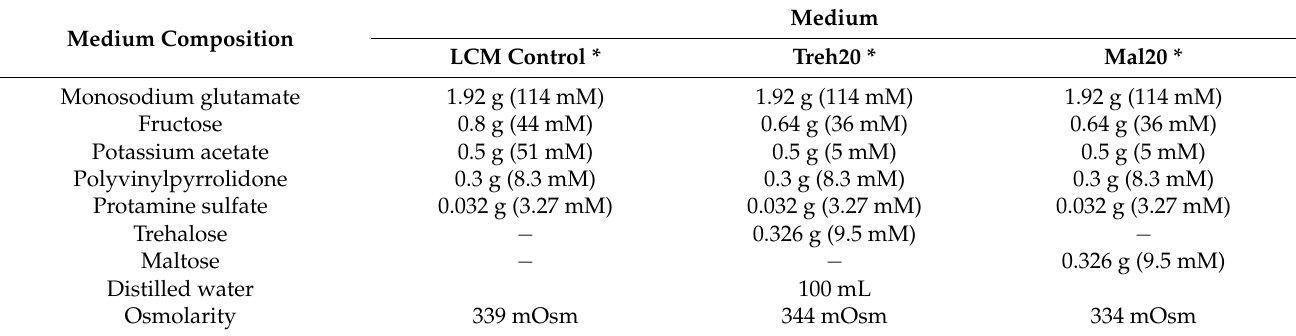
Table 5. Composition of media for freezing the semen of